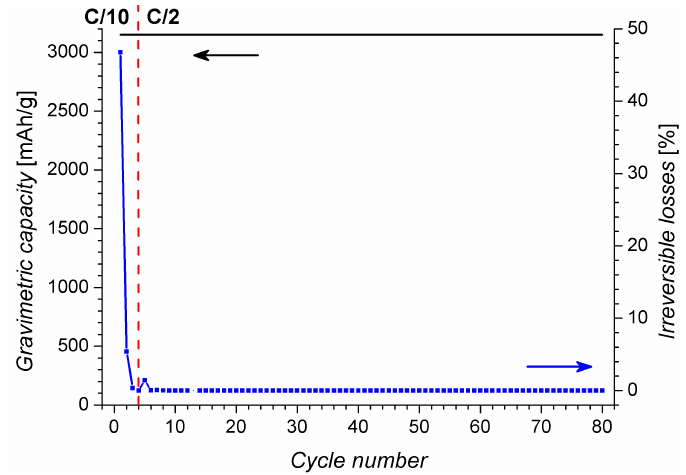
Figure 6. Cycling performance of the Si microwire anode with C /10 current for the first four cycles and C /2 current for the following ones. The capacity was limited to